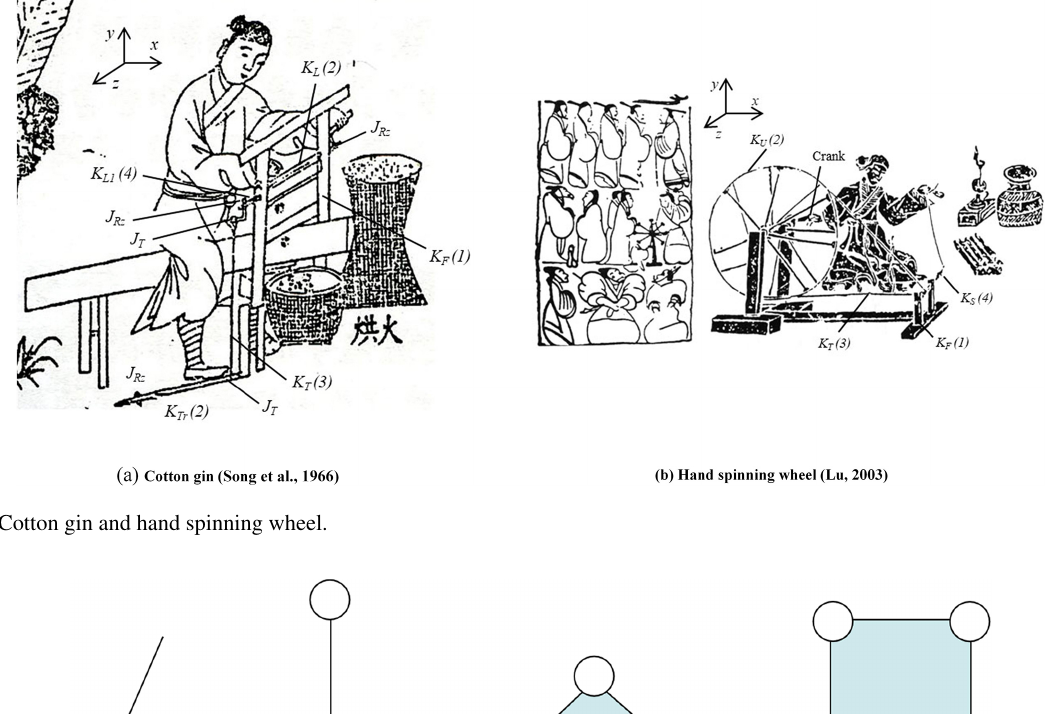
Figure 2. Expression by